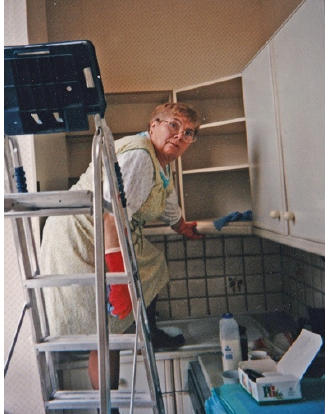
Figure 3. Virtudes working, with cleaning products, and tea PG. Virtudes (e misterioso) Xesús Fraga (2020, p. 88). Reprinted with permission from Xesús Fraga (2020). Copyright 2020 Copyright Owner’s Xesús Fraga.